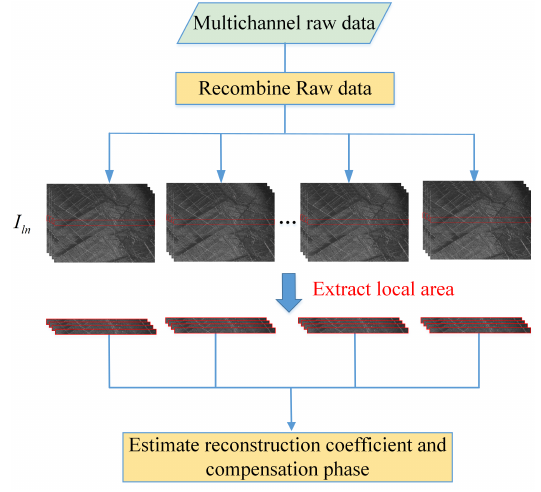
Figure 3. The local area estimation method.